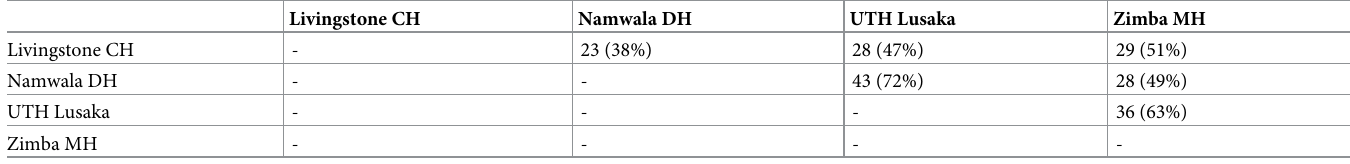
Table 2. Number of matching factors identified in the pairwise causal loop diagram comparisons, with average overlap in between brackets (relative to the total number of factors in the